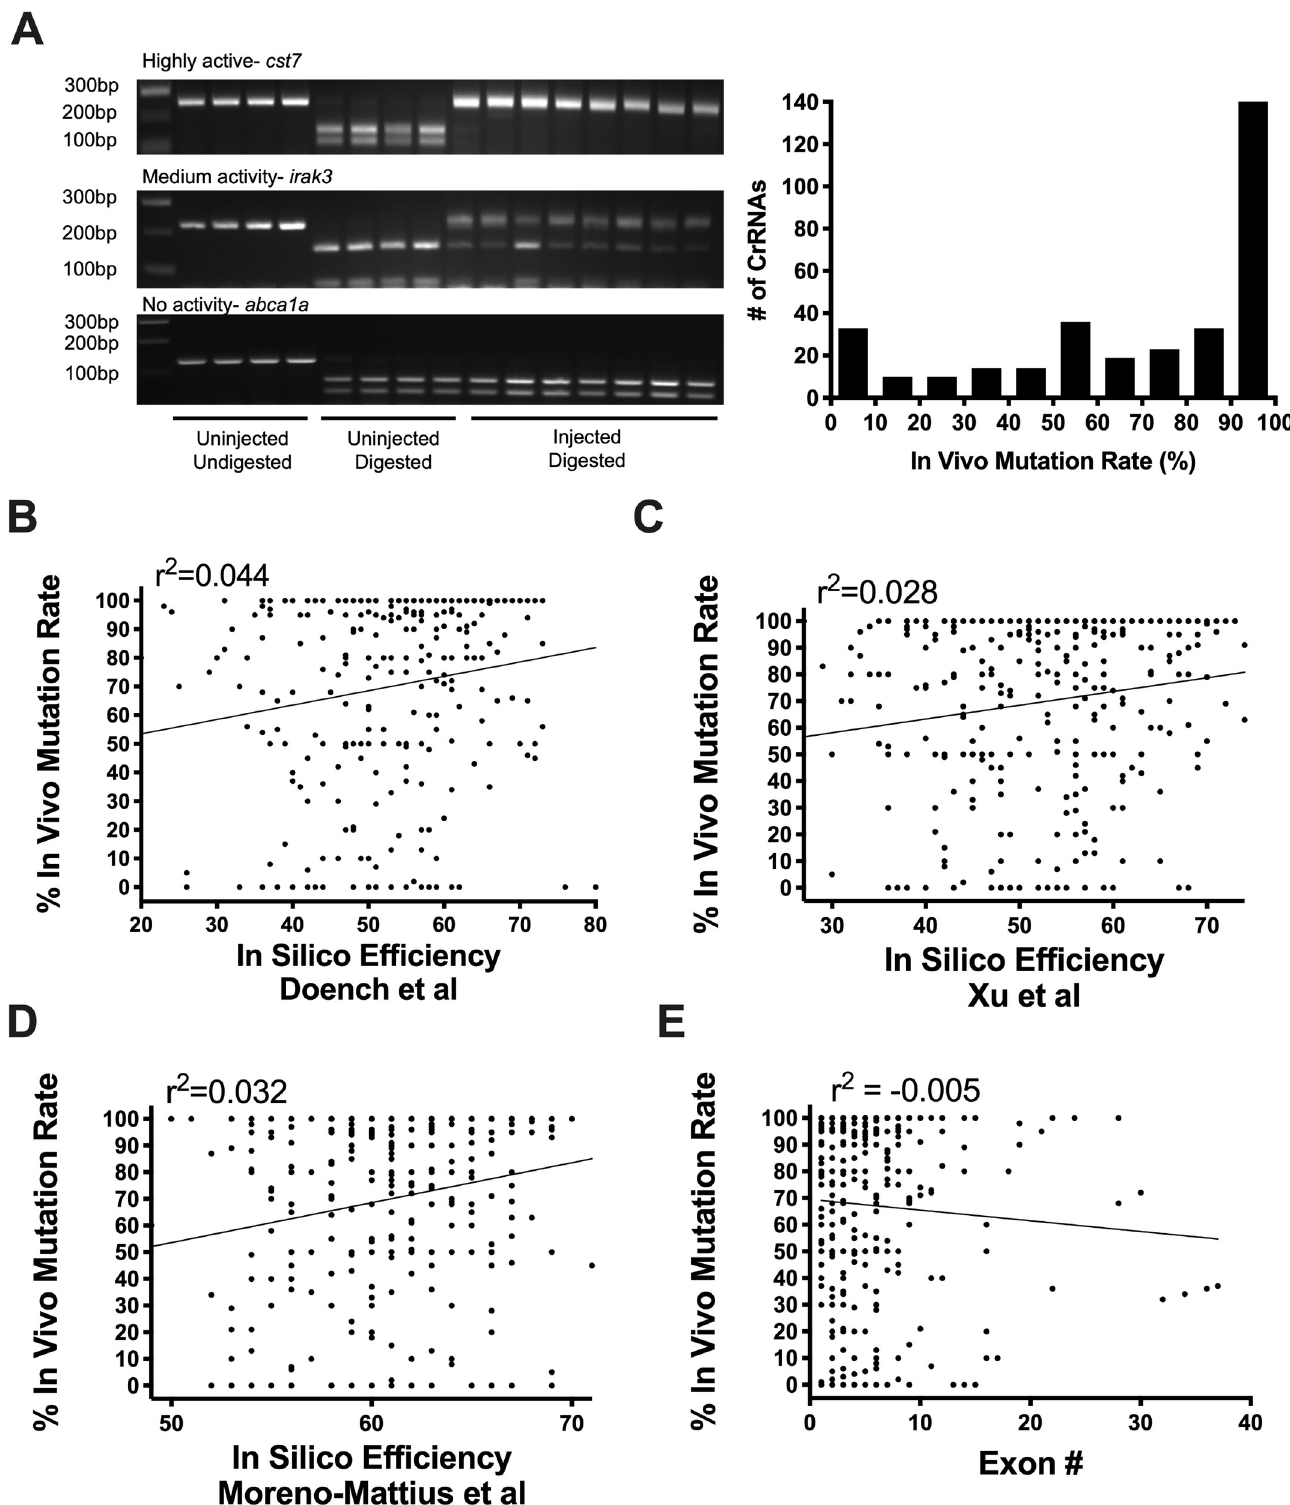
Fig 1. In vivo pre-screening identifies highly active sCrRNAs. A: Example gels to assess sCrRNA in vivo mutation rate by resistance to restriction enzyme digest (RFLP) are shown. These indicate > 90% mutation rate (top), medium mutation rate (middle) and no detectable mutation rate (bottom). Each lane is derived from one animal. The chart shows the distribution of > 350 sCrRNAs by in vivo mutation rate. B-D: Activities of individual sCrRNAs show weak correlation with predicted in silico efficiency using different prediction rules (see results). E: sCrRNA activities are not correlated with their relative position to the start codon in vivo .